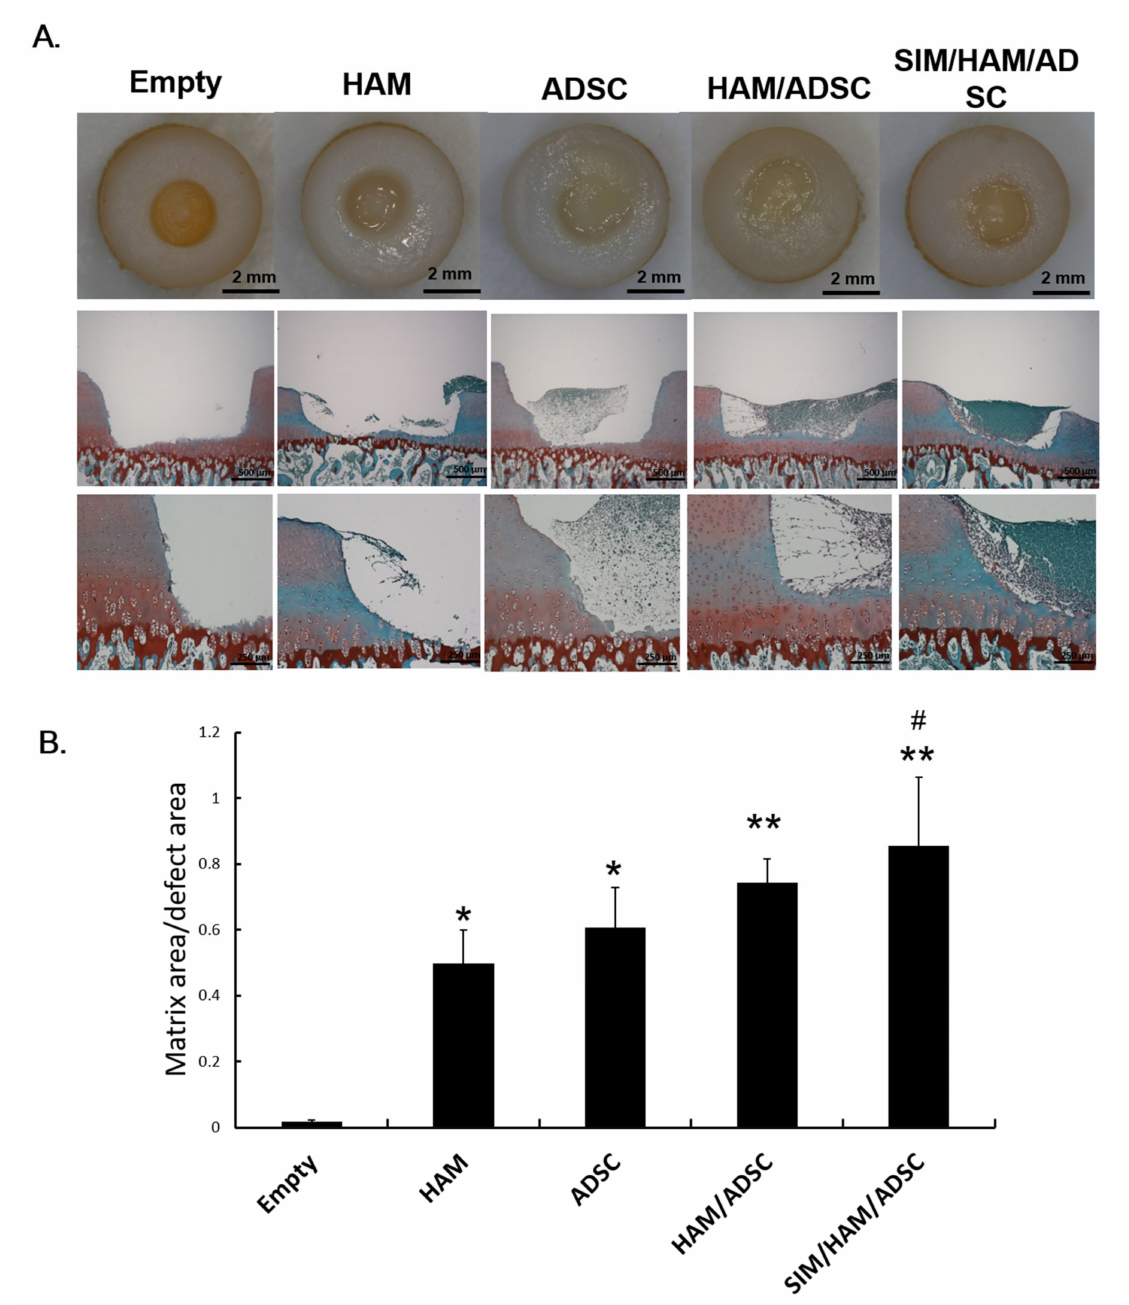
Figure 4. SIM plus 3D HAM increases the neoformation of cartilaginous tissue by ADSCs at the articular cartilage defect site. ( A ) Histological images of each group after safranin O and fast green staining. Representative micrographs of the empty, HAM, ADSC, HAM/ADSC and SIM/HAM/ADSC groups are shown. sGAG was stained red, and green indicates the counterstain. The original magnification was 40 × (scale bar = 1000 µ m) or 100 × (scale bar = 500 µ m). ( B ) Quantitative analysis of the percentage of neocartilaginous tissue formed at the defect site. The values indicate the ratio of neocartilaginous tissue formation to the defect area after 4 weeks of culture. The values are the means ± SEMs ( n = 5). (*) and (**) indicate p < 0.05 and p < 0.01, respectively, compared with the empty group. (#) indicates p < 0.05 compared with the HAM/ADSC